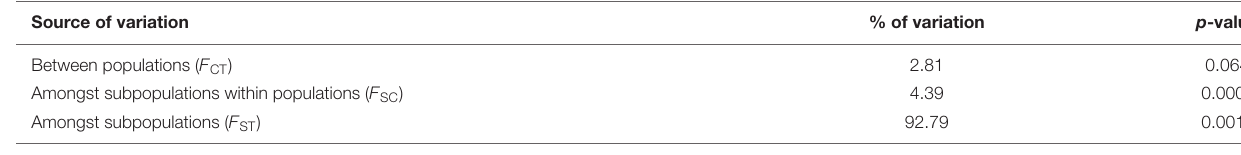
TABLE 5 | Analysis of molecular variance (AMOVA) analysis and inter-population F ST values. Source of variation % of variation p -value Between populations ( F CT )